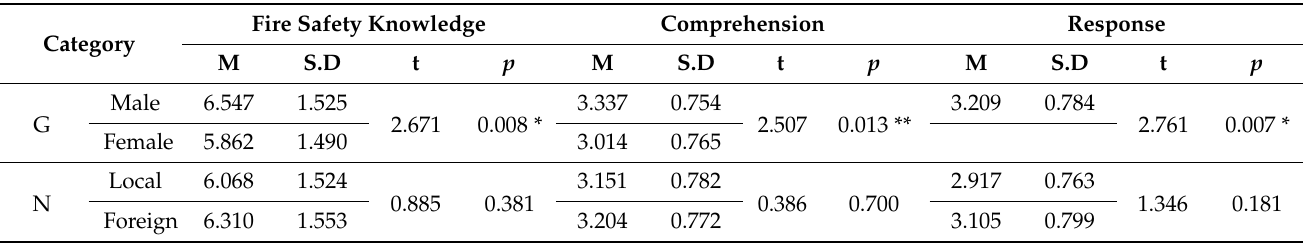
Table 4. Differences in fire safety knowledge, comprehension, and response score and t -test results according to respondents’ gender and nationality.